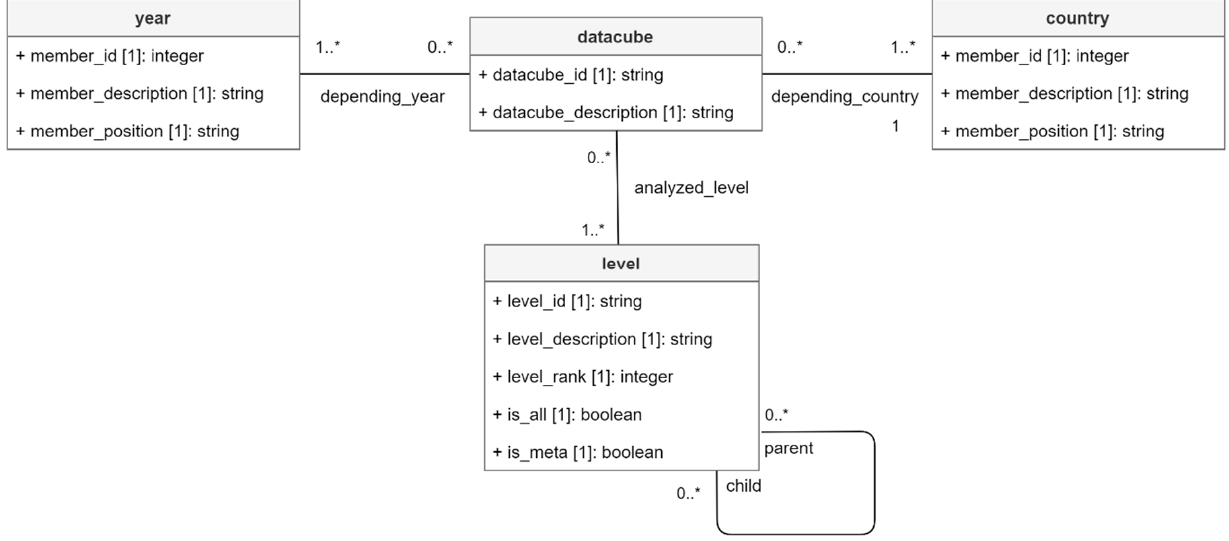
Figure 13. Metaclass datacube depending on metalevels year and country. Asterisk means “n” according to UML conven- tion.